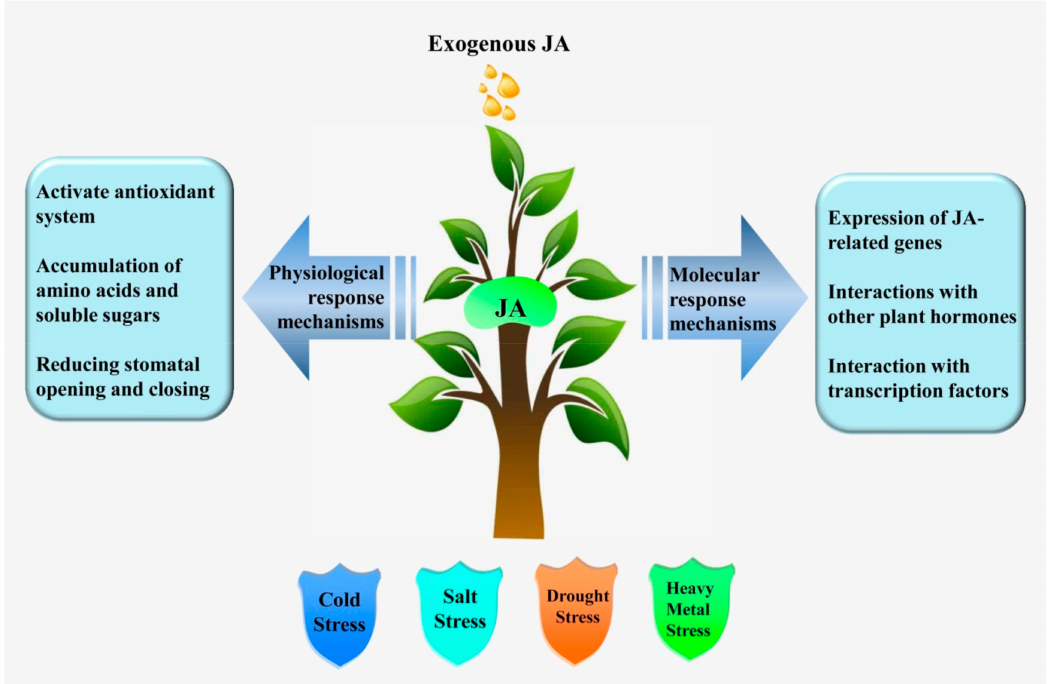
Figure 1. The role of jasmonic acid (JA) in plant response to abiotic